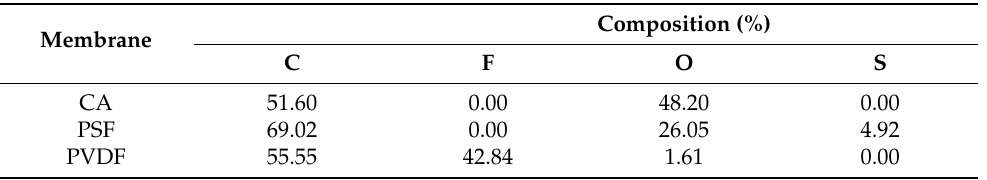
Table 2. The elemental composition of the cellulose acetate (CA), polysulfone (PSF), and polyvinyli- dene difluoride (PVDF)